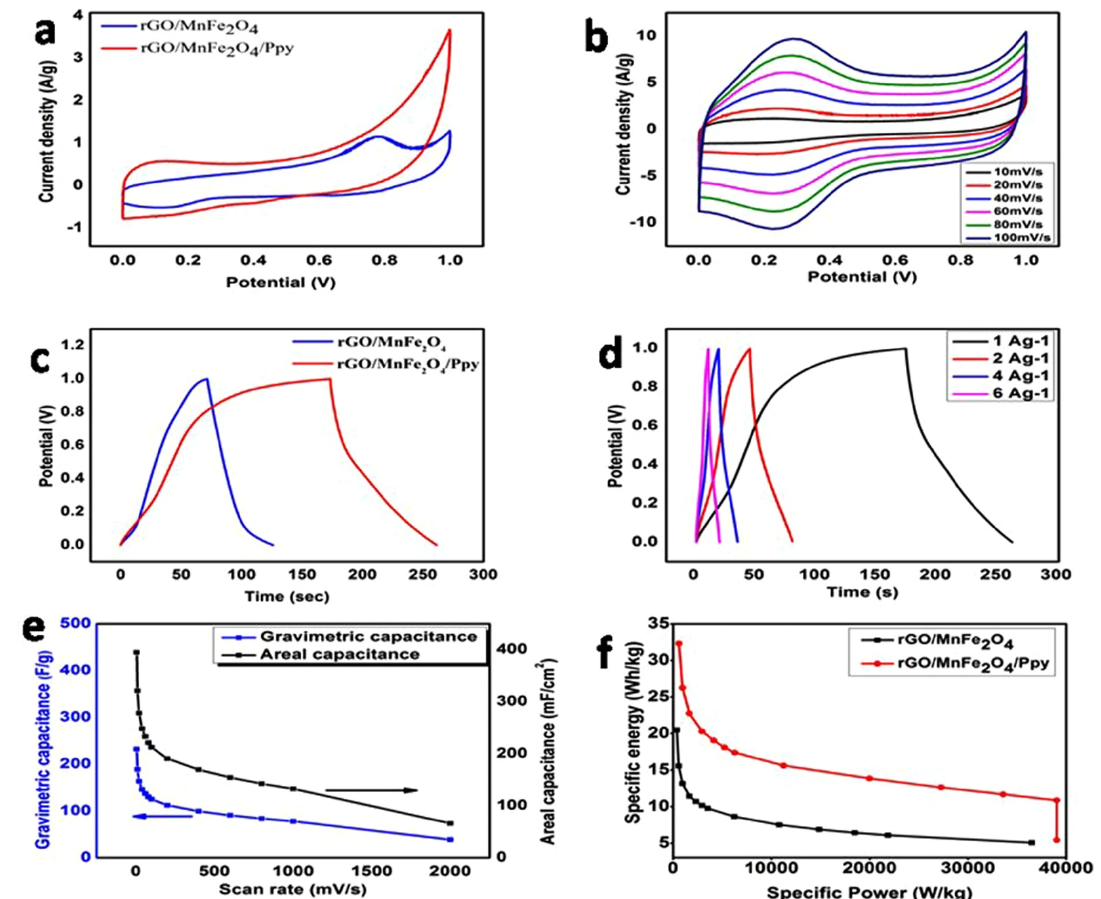
Figure 14. ( a ) CV curves at 5 mV · s − 1 . ( b ) CV curves for rGO / MnFe 2 O 4 / Ppy nanomaterial on various sweep rates. ( c ) CD curves on 1 A · g − 1 . ( d ) CD curves for rGO / MnFe 2 O 4 / Ppy on dissimilar current density. ( e ) Gravimetric and areal capacitance of rGO / MnFe 2 O 4 / Ppy on dissimilar sweep rates (5–2000 mV · s − 1 ) ( f ) Ragon designs of rGO / MnFe 2 O 4 plus rGO / MnFe 2 O 4 / Ppy on dissimilar sweep rates (5–2000 mV · s − 1 ). Reproduced with permission from [106].